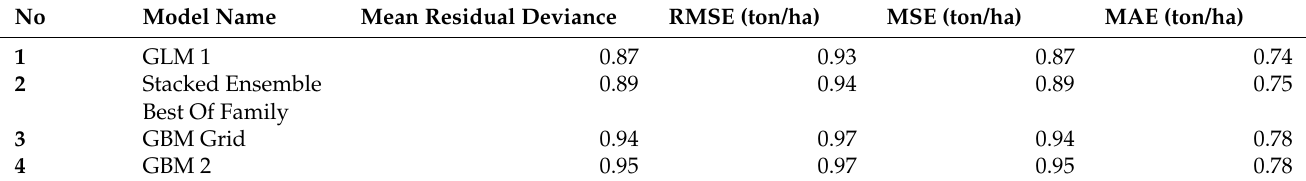
Table 3. Table showing the performance of the top four component algorithms of the AutoML